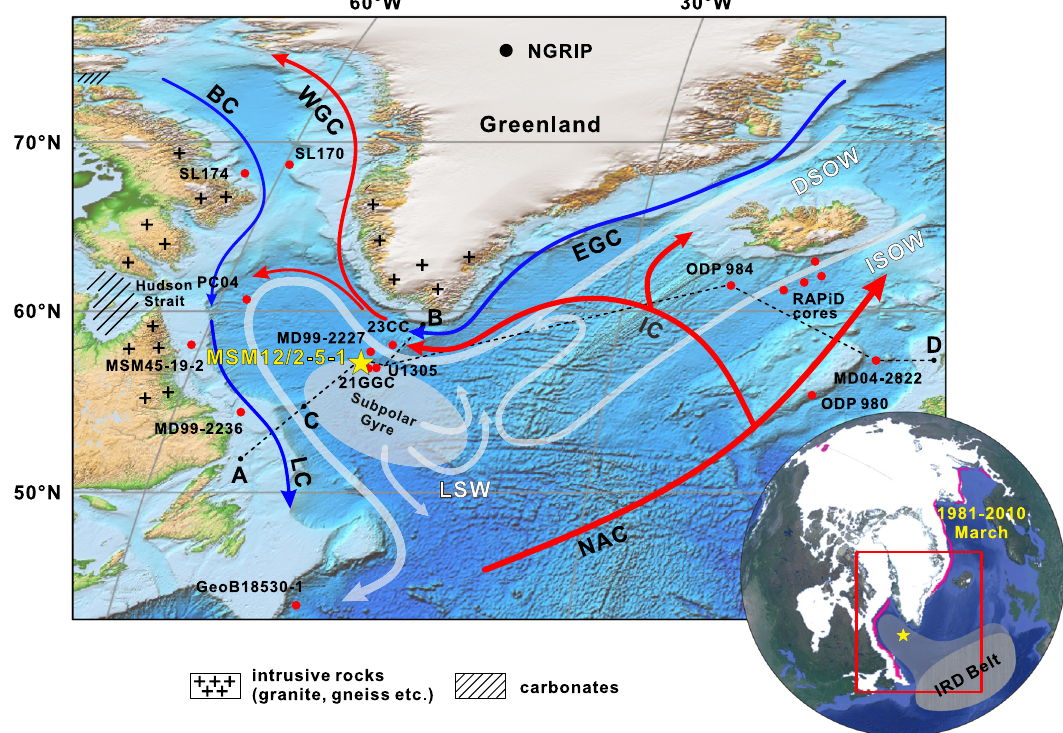
Fig. 1 Core sites and regional context of the study area. Main map with core sites and modern ocean circulation pattern. Yellow star: Core MSM12/2-5-1; red dots: other cores referred to; red arrows: warm surface currents; blue arrows: cold surface currents; white arrows: deep and intermediate currents. NAC North Atlantic Current, IC Irminger Current; WGC West Greenland Current, EGC East Greenland Current, BC Baf fi n Current, LC Labrador Current, DSOW Denmark Strait Over fl ow Water, ISOW Iceland-Scotland Strait Over fl ow Water, LSW Labrador Sea Water. Black stippled lines A to B and C to D show location of hydrographic transects presented in Supplementary Fig. 1. Simpli fi ed bedrock geology based on ref. 87 . Map was taken from ETOPO1 (source: https://www.ngdc.noaa.gov/mgg/global/). Small overview map (right lower corner) with average sea ice extent of 1981 – 2010 March (image modi fi ed from Google Earth, data source: https://nsidc.org/), IRD belt (dark grey shading) 21 , distribution range of cores with IRD signal around the Labrador Sea (light grey shading) 88 , and the study area (red